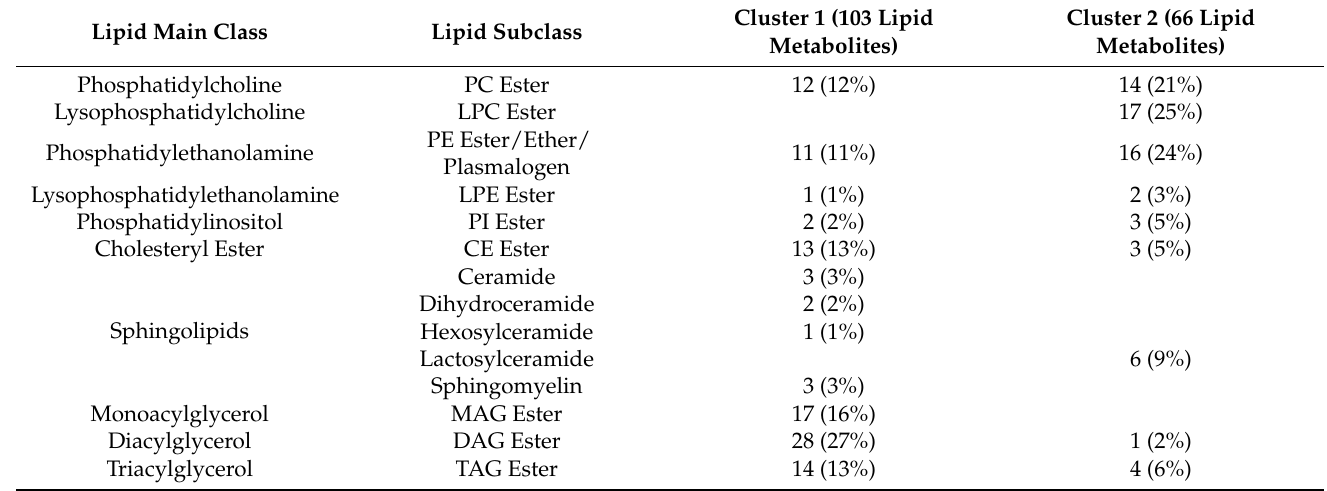
Table 7. The classification of lipid metabolites showing significantly different levels when comparing patients with and without pretransplant inflammation, early postconditioning fluid overload and posttransplant acute GVHD. The table shows the number of different lipid metabolites (and their percentages) in the two main clusters identified in the unsupervised hierarchical cluster analysis, based on the lipid metabolites that differed significantly between patients with and without inflam- mation/fluid overload/acute GVHD (see Figure S2). A more detailed presentation showing the number of metabolites found in each of the six subclusters is presented in Table S6. Cluster 1 (103 Lipid Subclass